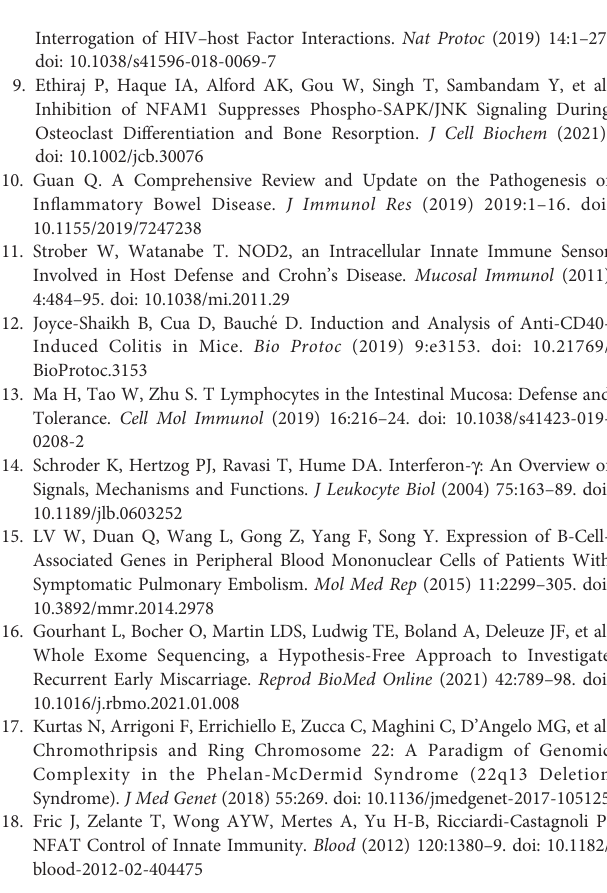
Supplementary Figure 4 | Thioglycolate-induced peritoneal macrophages from NFAM1 -/- mice produce reduced TNF- a in response to stimulation with IFN- g and CD40L. 4 NFAM1 +/+ and 4 NFAM1 -/- mice were given an intraperitoneal injection of 3% thioglycolate. On day 3, mice were sacri fi ced, peritoneal lavage was collected, andmacrophageswereisolated via centrifugation.Shownisquanti fi cationofTNF- a in the supernatant at 48 hours post stimulation with IFN- g and CD40L. Data are combined from two independent experiments for a total of 8 NFAM1+/+ and 8 NFAM1-/- mice. Statistical signi fi cance is depicted as follows: * indicates a P value of <0.05 and ns indicates the comparison is not statistically signi fi cant. Supplementary Figure 5 | There is no signi fi cant difference in T cell-mediated cytokine production in NFAM1 -/- and NFAM1 +/+ mice. (A – C) 10 NFAM1 -/- and 10 NFAM1 +/+ mice were immunized at the base of the tail with OVA emulsi fi ed in complete Freund ’ s adjuvant. On day 10, inguinal lymph nodes were isolated and restimulated with 0, 11, 33.3 or 100 µg/mL of OVA. Mean IFN- g production is shown in (A) , mean IL-17 production is shown in (B) , and mean TNF- a production is shown in (C) . Data are representative of two independent experiments. NS indicates the comparison is not statistically signi fi cant. Supplementary Figure 6 | NFAM1 promotes CD40L-induced cytokine and chemokine production in human monocytes. (A – G) Human monocytes from 1 donorweretreatedwithNon-targeting(NT)CRISPR-RNPorNFAM1CRISPR-RNP. Cells were plated in duplicate and stimulated with CD40L for 24 hours. Shown are NFAM1 protein expression (A) and MIP-1 b (B) , TNF- a (C) , IL-8 (D), IL-1 b (E) , IL-1Ra (F) and CCL22 (G) as measured in the supernatant by